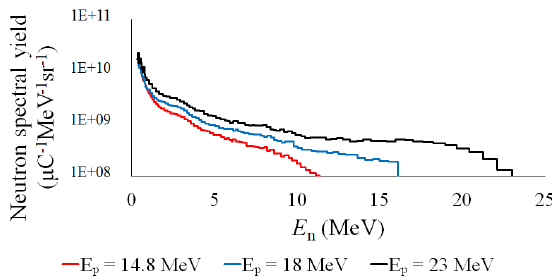
Figure 1. Neutron energy spectra from the source reaction p+Be measured by Lone et al. for proton energies of 14.8 MeV, 18 MeV and 23 MeV [9, 11].